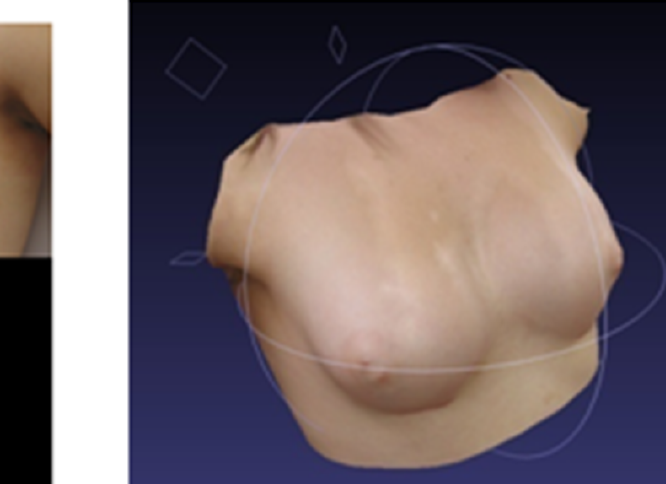
Figure 6. Overlapping scanner views (left) and the resulting surface scan generated by the commercial scanner software